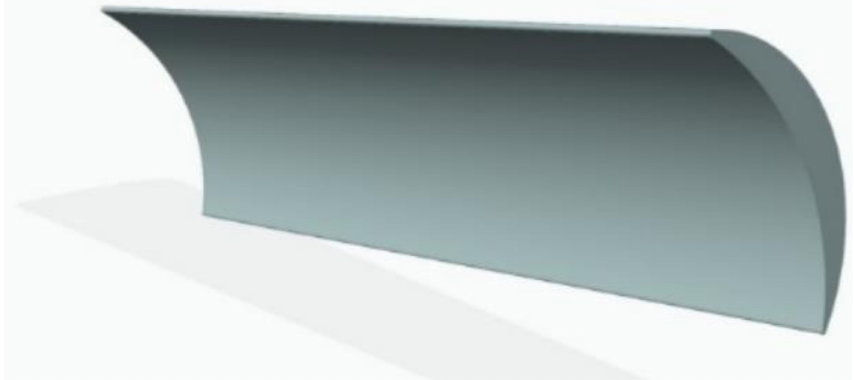
Figure 12. CAD model of one blade with t max = 7 mm.